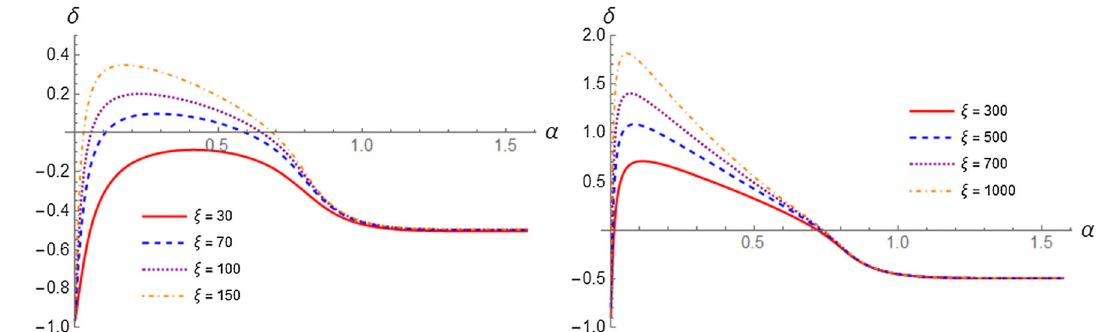
Fig. 11 Plots of the relative change of the absolute value of velocity δ αα (cid:2) (ξ) as a function of the incidence angle α for large values of the anisotropy parameter ξ = 30 (solid), ξ = 70 (dashed), ξ = 100 (dotted) and ξ = 150 (dash-dotted)